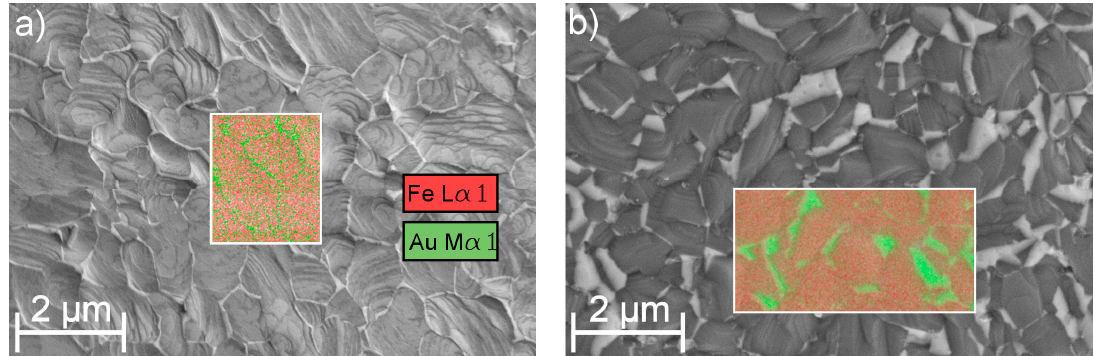
Figure 6. SEM surface image and EDX elemental mappings of the Fe-L- α and Au-M- α lines for ( a ) a FeAu1.0 and ( b ) FeAu2.5 sample annealed at 800 °C, 2 h. In the SEM image Au precipitates appearing bright due to the Z-contrast.